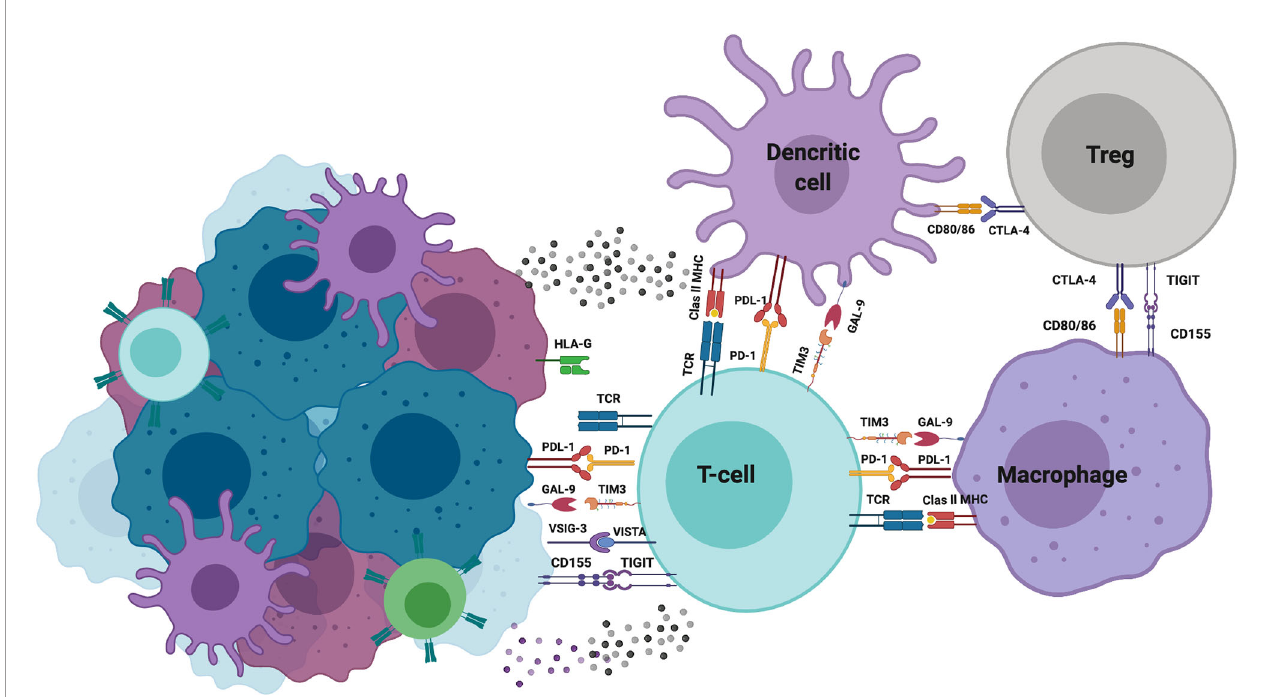
FIGURE 4 | Immune checkpoint molecules. Schematic representation of the main checkpoint molecules with inhibitory activity expressed in immune and tumor cells as a mechanism of immune evasion. Created with